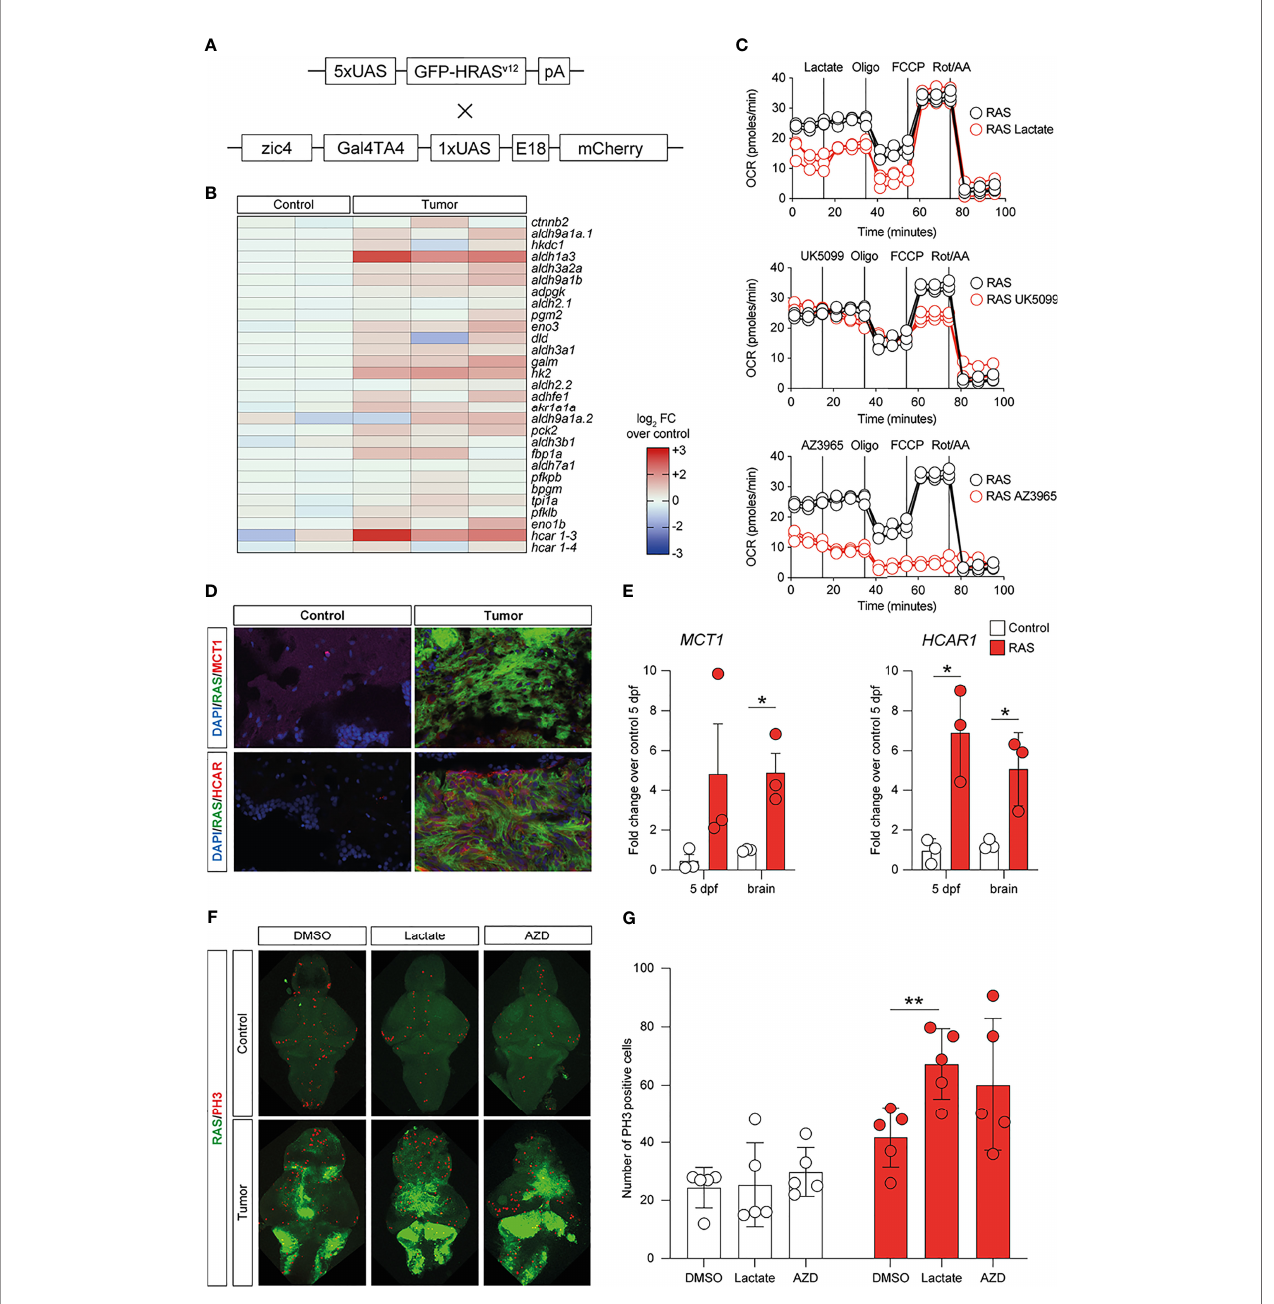
FIGURE 6 | Metabolic changes in a zebra fi sh model of glioblastoma (GBM) led to increased glycolysis and lactate transport and sensing. (A) Schematic representation of the genetic components of the zebra fi sh GBM model (Mayrhofer et al., 2017). (B) Increased expression of several members of the glycolytic pathway in GBM. Heatmap representing 29 glycolysis genes and their relative expression levels. (C) Analysis of mitochondrial metabolism (acute Mito Stress test) of tumor cells with the Seahorse XP technology. Each experiment was performed in triplicate and normalized to the number of cells. (D) Increased levels of HCAR1 in tumors vs . control as visualized by immuno fl uorescence. Staining as detailed in the fi gures, which are representative of at least three different experiments. (E) Gene expression analysis through quantitative PCR (qPCR) expressed as fold changes compared to controls, at 5 days post-fertilization and in adult tumors. Values represent the mean ± SEM of experiments performed in triplicate. P -values <0.05 were considered as statistically signi fi cant (* p < 0.05 vs . controls). (F) Whole-mount immuno fl uorescence of Ph3 proliferating cells in controls and in HRAS-overexpressing larvae treated or not with 20 mM lactate. Green fl uorescence represents tumoral cells expressing eGFP-HRASG12V. (G) Number of proliferating cells in the brains treated as